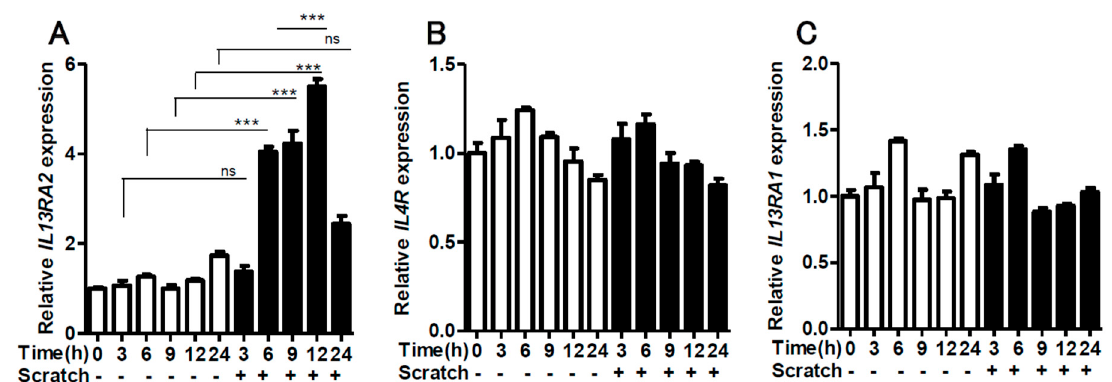
Figure 2. Time-course study for IL13RA2 ( A ), IL4R ( B ), and IL13RA1 ( C ) expression. The gene expression of IL13RA2 , IL4R , and IL13RA1 was measured with or without scratching at 0, 3, 6, 9, 12, and 24 h ( n = 3). Data is shown as the mean ± SEM. ns: not significant. *** p < 0.001.